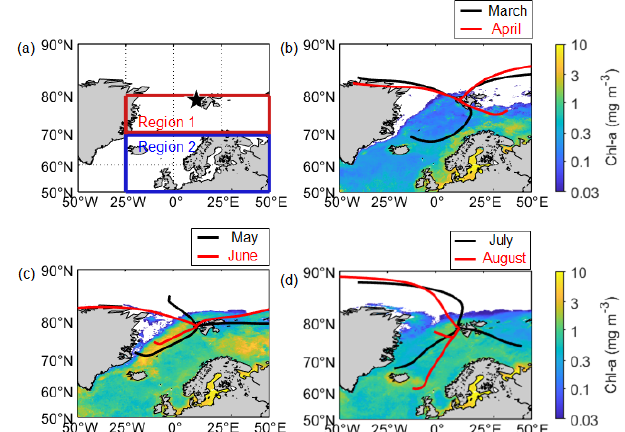
Figure 1. (a) Location of the aerosol sampling site (black star; Gruvebadet observatory; 78.9 ◦ N, 11.9 ◦ E) and the ocean domains (70–80 ◦ N, 25 ◦ W–50 ◦ E for Region 1; 50–70 ◦ N, 25 ◦ W–50 ◦ E for Region 2) defined for this study. Mean Chl- a concentration for (b) March and April, (c) May and June, and (d) July and August over the period of 2015–2019, overlaid with air mass trajectory clus- ters that represent the dominant pathways of air masses reaching the observation